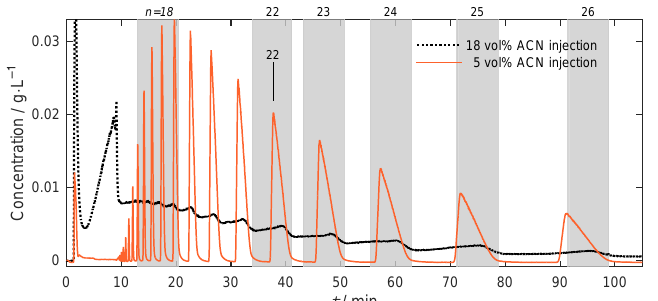
Figure 7. Large-volume injections on the preparative column under strongly diluted conditions. Black—sample dissolved in the eluent. Orange—sample dissolved in pure water. For compari- son, elution windows predicted by the thermodynamic model are marked for selected homologs. Conditions: 18 vol% ACN, 50 ◦ C, injection of 150 mL PEG 1000 with 0.05 g/L.